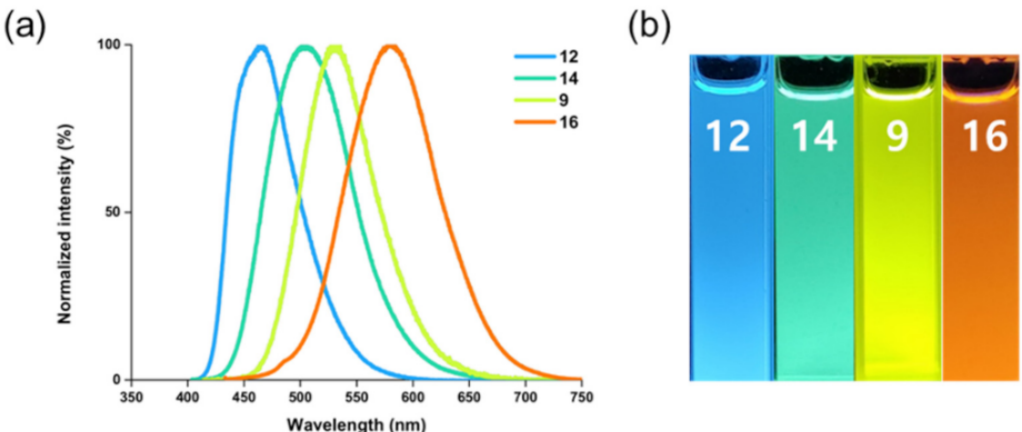
Figure 4. ( a ) Normalized emission spectra of representative compounds 12 (blue), 14 (green), 9 (yellow), and 16 (red-orange). ( b ) Fluorescence photo image of each compound in MeOH taken under 365 nm UV light